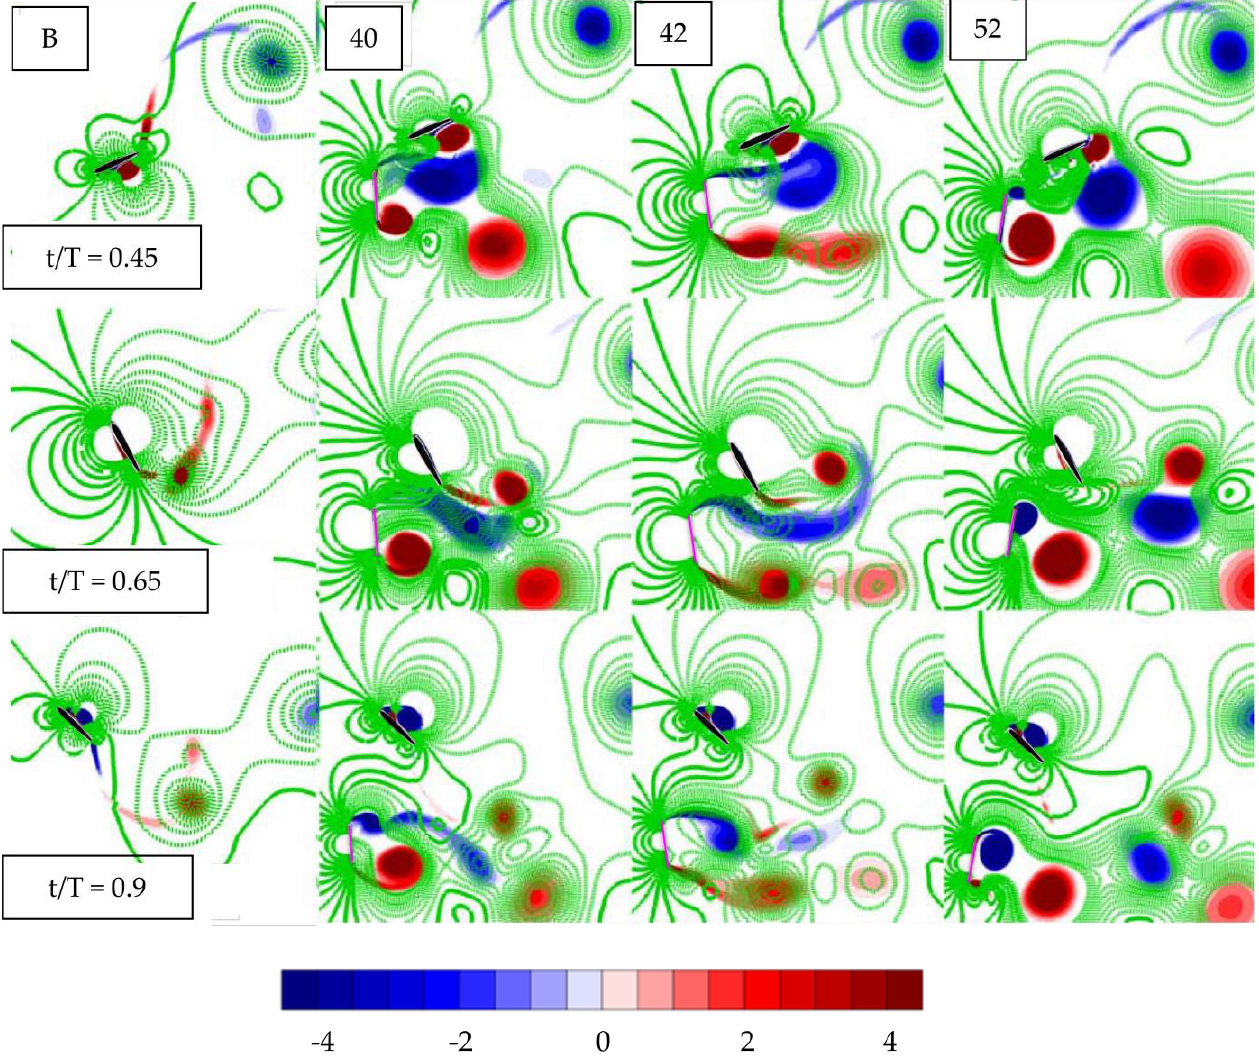
Figure 20. A comparison of the vortex structures and isolines of pressure of an oscillating hydrofoil for different tilt angles of the upstream deflector during upstroke (solid isolines: positive pressure; dashed isolines: negative pressure).